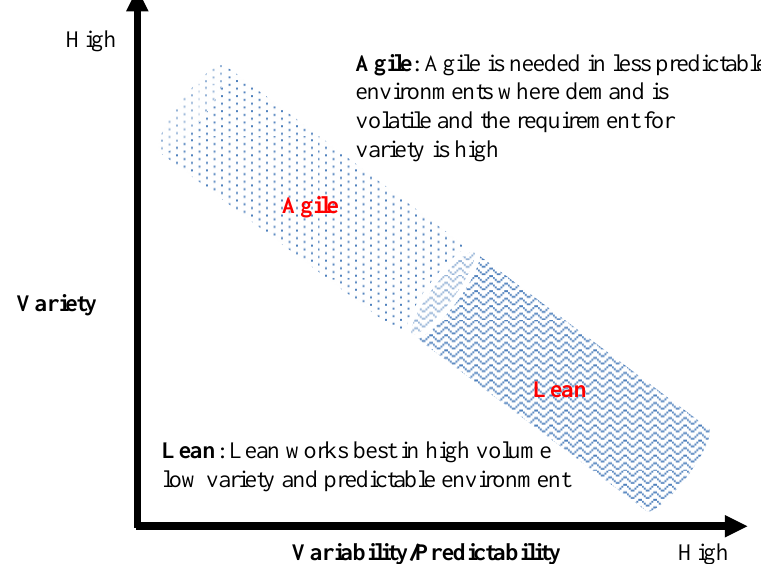
Fig. 2. SCM strategy of agile verses leanness (figure modified from Christopher